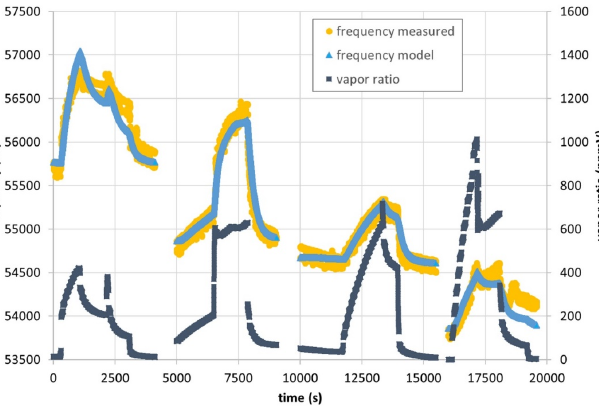
Figure 14. Frequency response of #162 functionalized microcantilever exposed to humid air (up to 1000 ppmV of water) and model fit with the parameters shown in Table 4 Set 2. Temperatures 16 ◦ C (0 to 4100 s), 25 ◦ C (5000 to 9000 s), 45 ◦ C (10,000 to 15,500 s) and 55 ◦ C (16,000 to 19,600 s). Pressure values between 970 and 1100